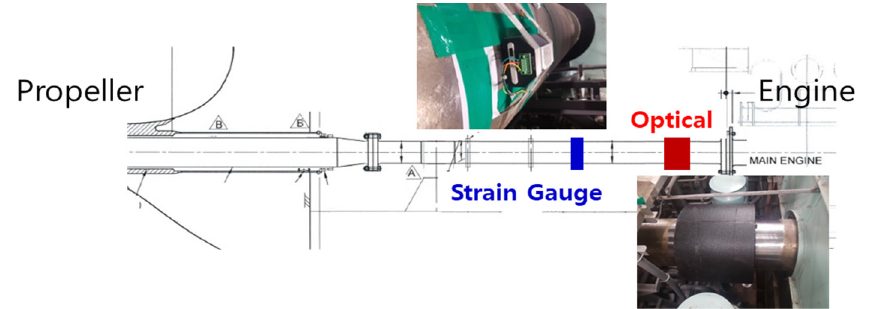
Figure 6. Location of the measurement systems.